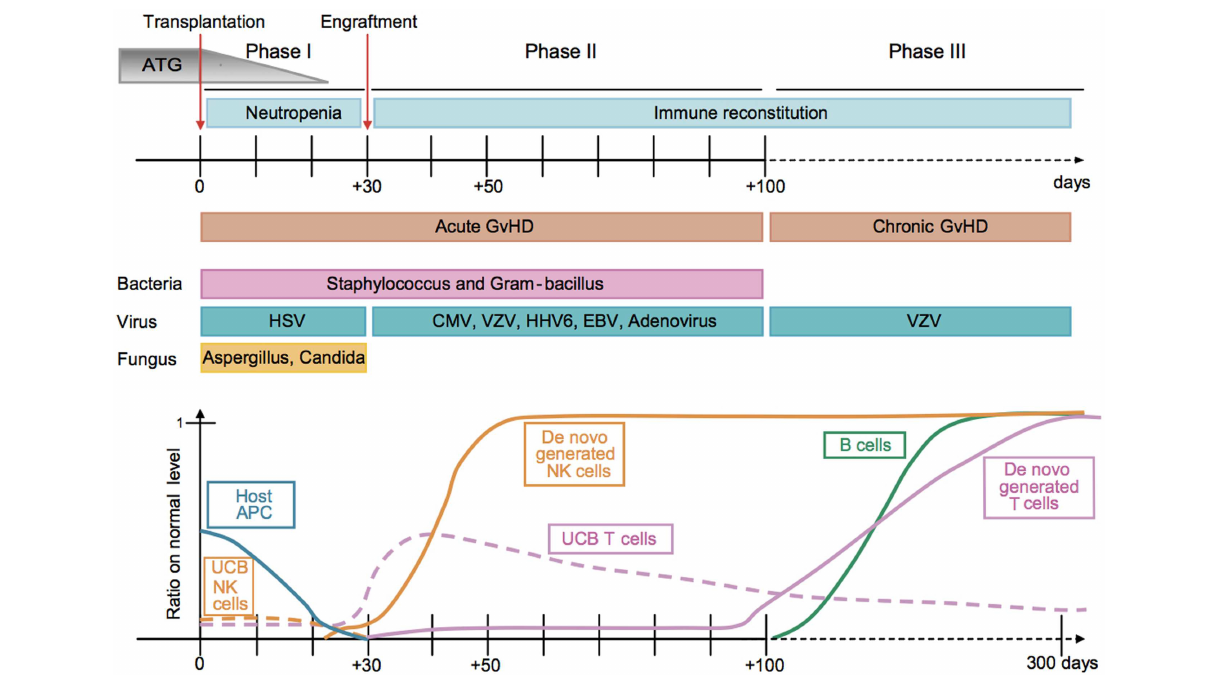
FIGURE 1 | Kinetics of immune reconstitution and transplant-related complications in children following UCB transplantation .The post-transplantation period can be divided in three phases.The pre-engraftment period (Phase I, days 0–30) is characterized by general immunosuppression (i.e., depletion of lymphocytes in the recipient by ATG), neutropenia, low platelet counts, and high susceptibility to fungal infections. Host residual APCs progressively disappear during Phase I. Massive proliferation leads NK cells to reach normal levels within 1month post-transplantation.They may represent 80% of the recipient’s PBLs during the post-engraftment period (Phase II, days 31–100). During Phase II, patients